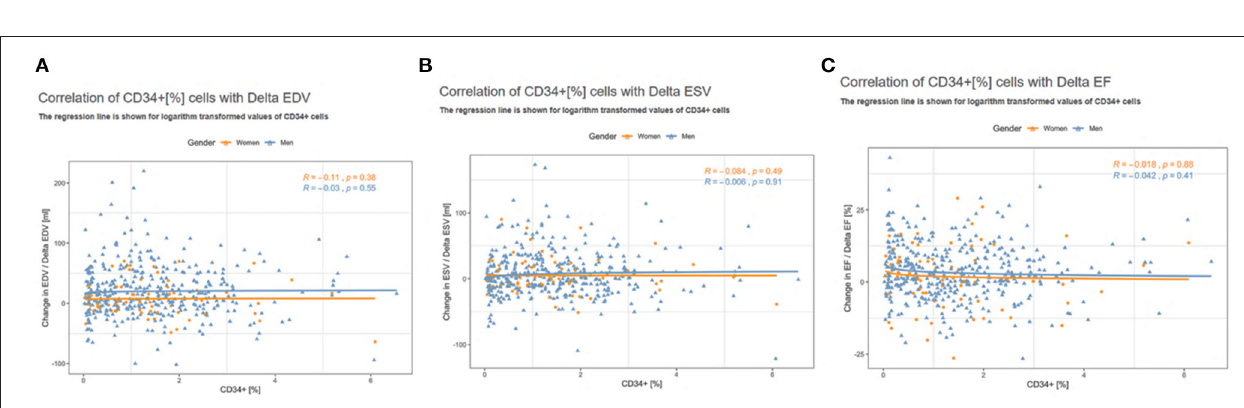
FIGURE 5 | Correlation of CD34 + cells left ventricular functional data. (A) Delta EDV. (B) Delta ESV. (C) Delta EF. The regression line is shown for logarithmic transformed values of bone marrow CD34 +